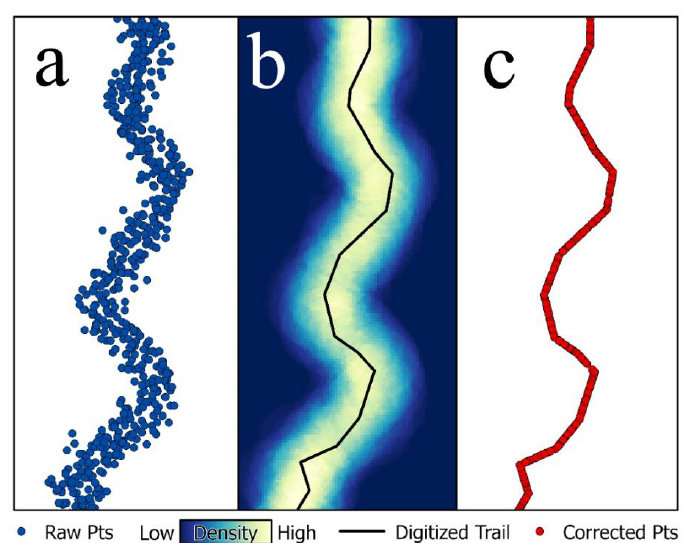
Figure 1. ( a ) Raw global positioning system (GPS) points representing instantaneous locations of firefighters as they traverse along a single-track trail, with positional error; ( b ) point density raster dataset used to digitize a line representing the average GPS position and the “true” trail; ( c ) corrected GPS points with locations snapped to the trail.